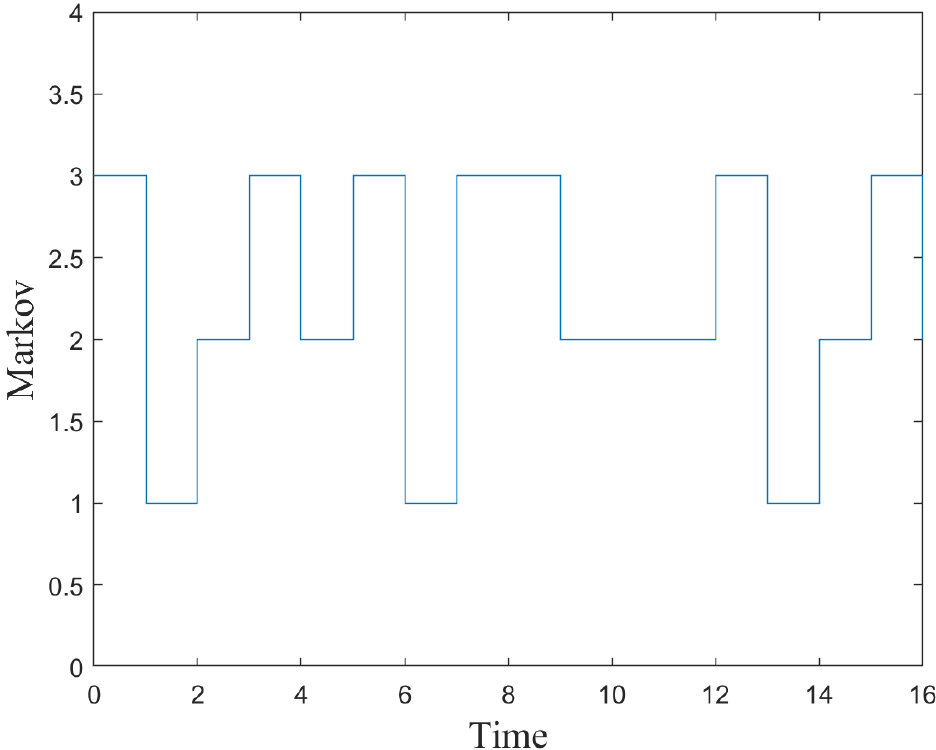
Figure 7. Markovian change